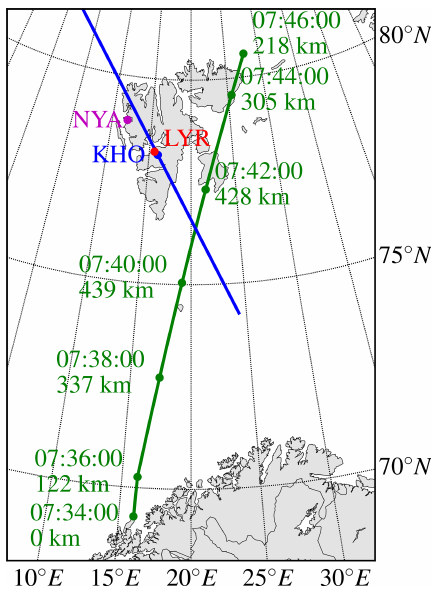
Figure 1. Figure showing the ground track for the RENU2 rocket (green) and the meridian-scanning photometer (MSP) scan line (blue) when scanning above 20 ◦ elevation angle. The locations of Longyearbyen (LYR), Ny-Ålesund (NYA) and the Kjell Henrisken Observatory (KHO) are